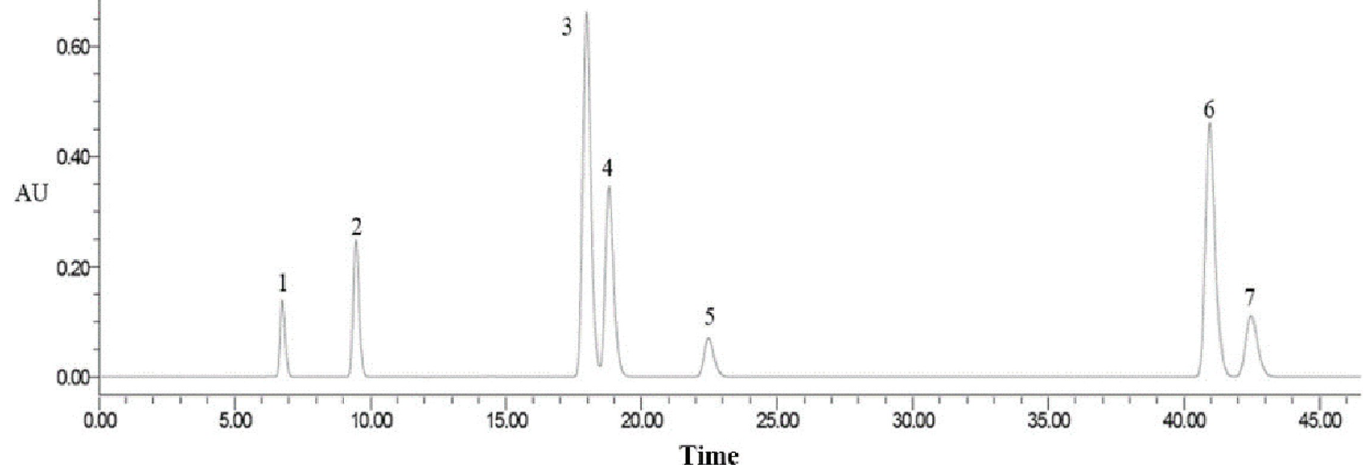
Fig 2. HPLC chromatograms of mixed standards. 1. L-PHE; 2. protocatechuic acid; 3. eleutheroside B; 4. chlorogenic acid; 5. caffeic acid; 6. eleutheroside E; 7. isofraxidin.